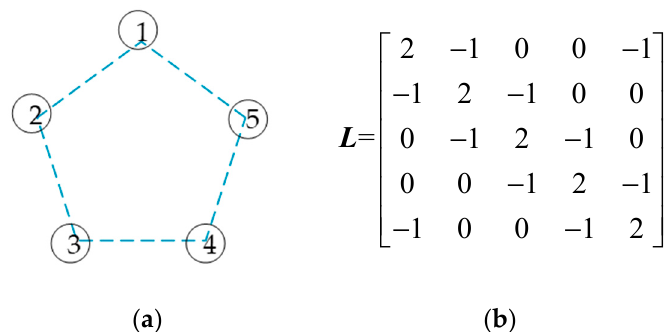
Figure 9. Communication topology and its Laplacian matrix. ( a ) A topological structure with five information nodes; ( b ) Laplacian matrix.